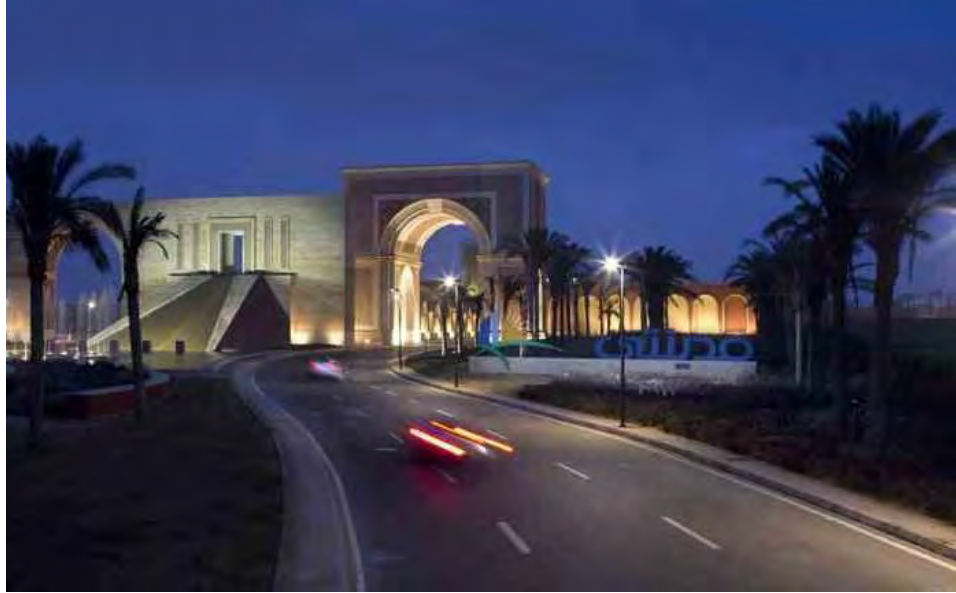
Fig. 2: Madinty streets.